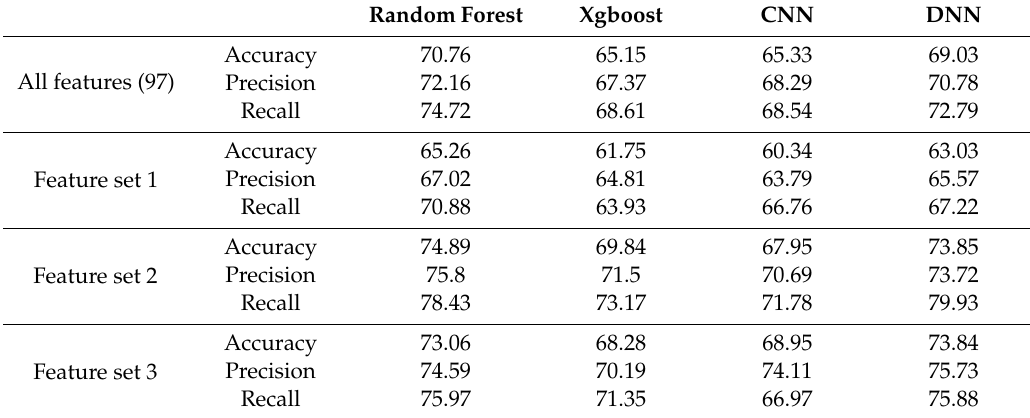
Table 6. Results on prediction performance using statistical features.